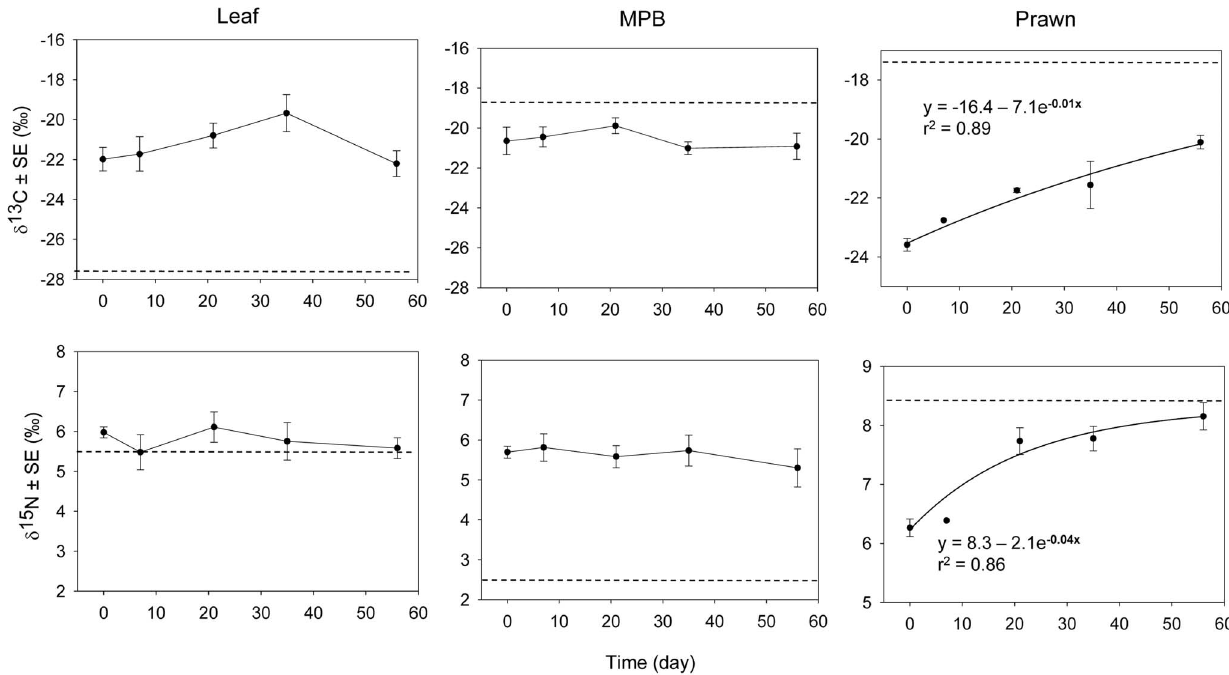
Figure 3. d 13 C and d 15 N profiles of crabs on the mangrove leaf, MPB, and prawn diet. Temporal changes in stable isotope values of the muscle tissues of crabs fed the potential dietary items are indicated by the solid lines. Mean d 13 C and d 15 N values of the tested food are presented as the broken horizontal lines. For the prawn-feeding data, the best fitting curves are plotted with the respective exponential functions and r 2 values.